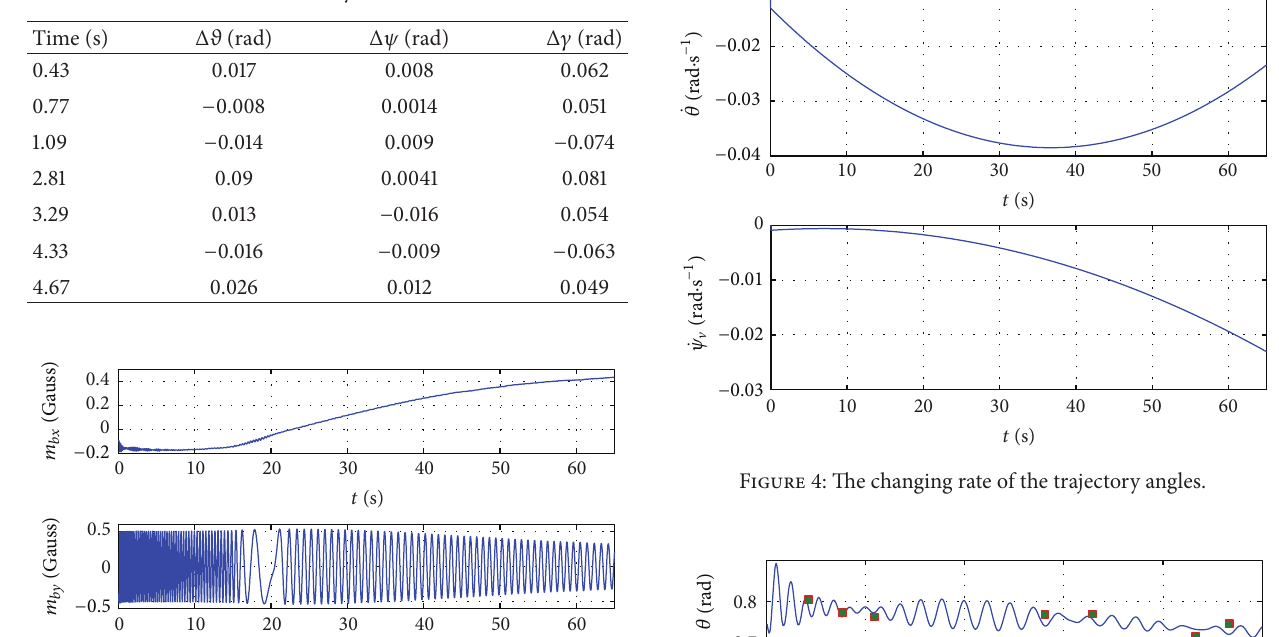
Table 1: Attitude error by fast coarse method.